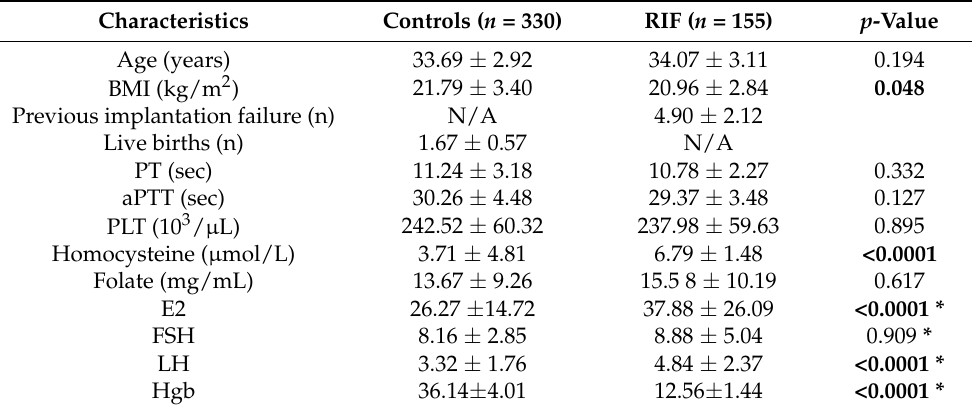
Table 1. Clinical profiles of RIF patients and control